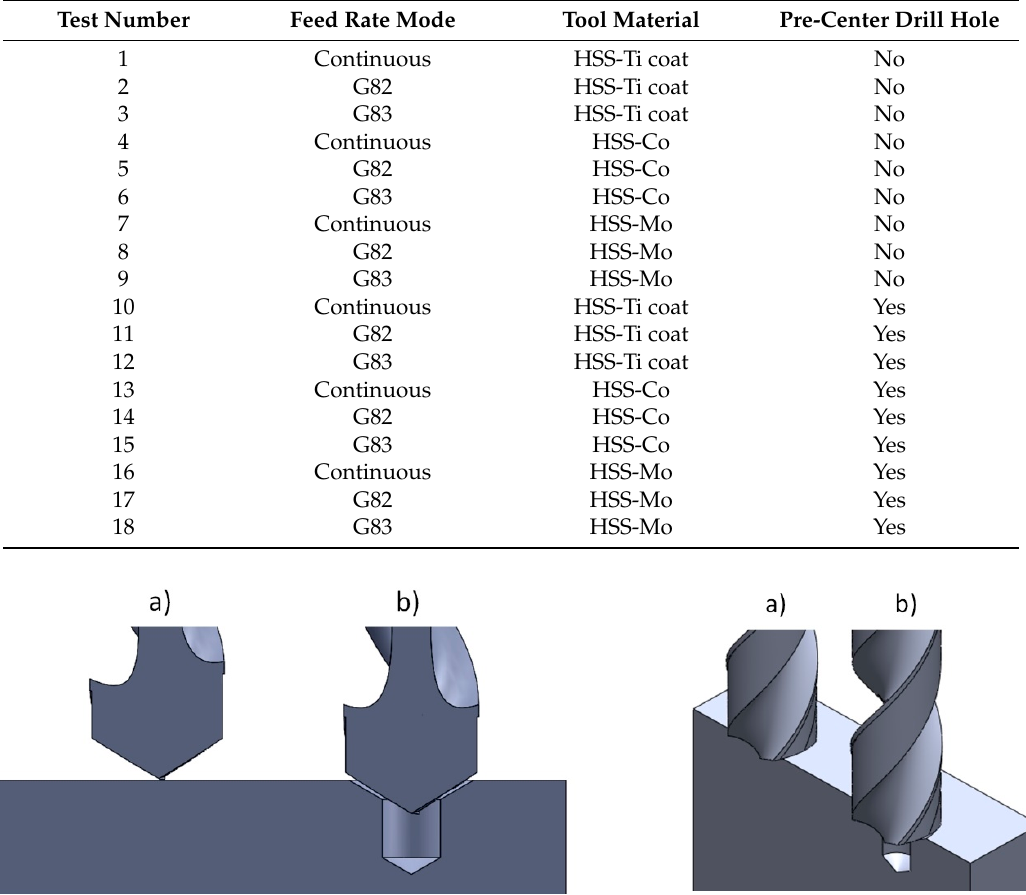
Table 4. Design of Experiment.